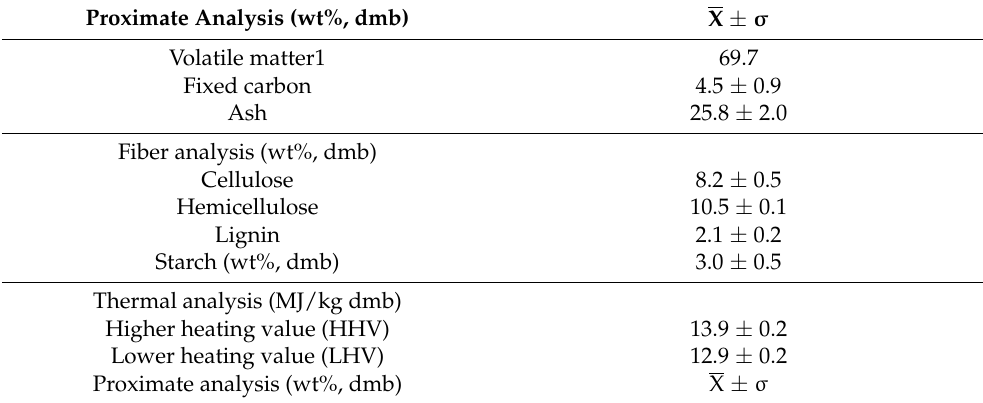
Table 4. Proximate, fiber, and thermal analyses of prickly-pear cladodes.